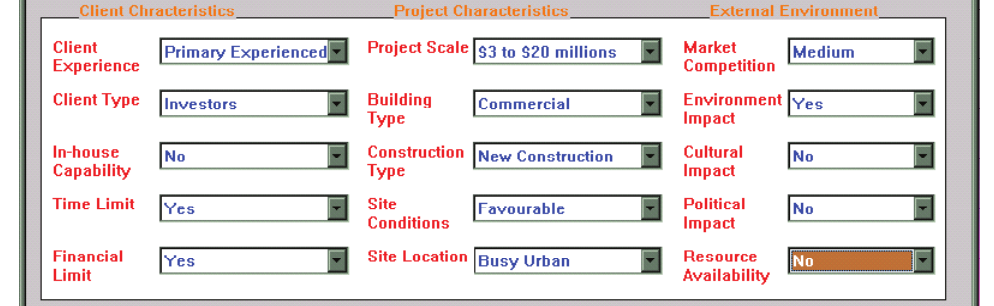
Figure 4: Interface for extracting the characteristics of client, project and environment